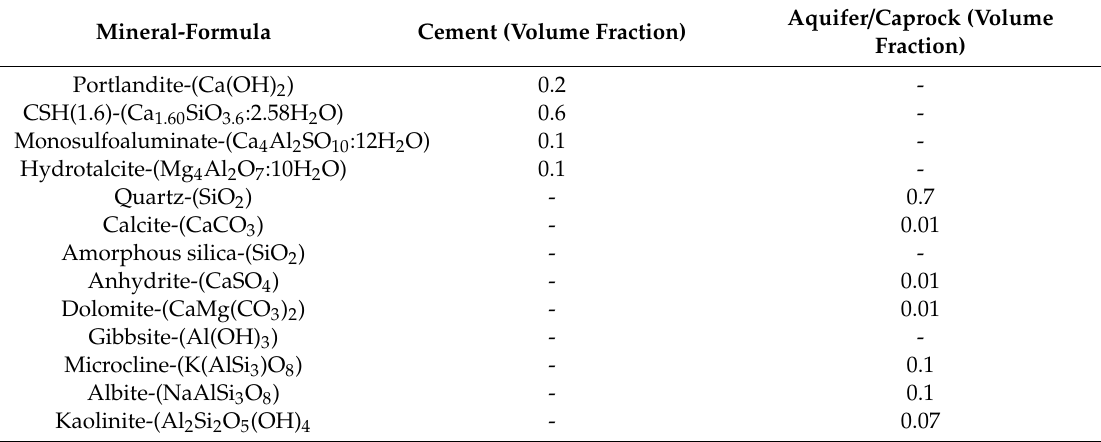
Table 2. Initial mineralogy of cement and aquifer / caprock and possible secondary